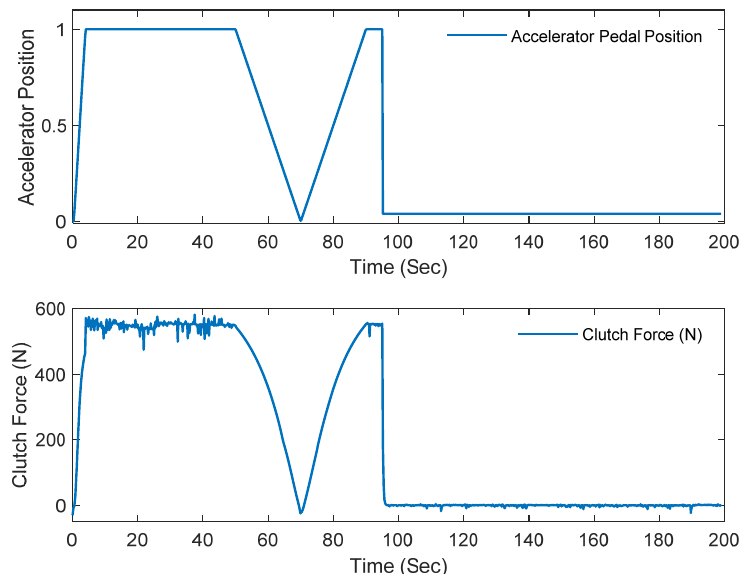
Figure 11. Slipping ratios and speeds.